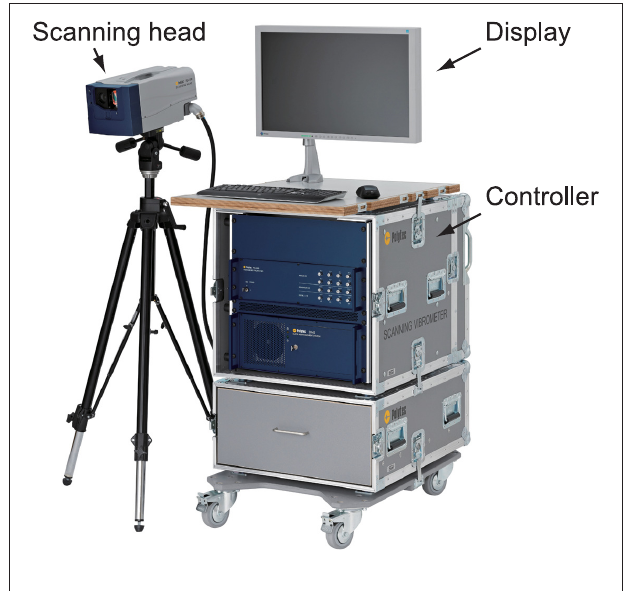
FIGURE 1 | Scanning laser Doppler vibrometer, Polytec